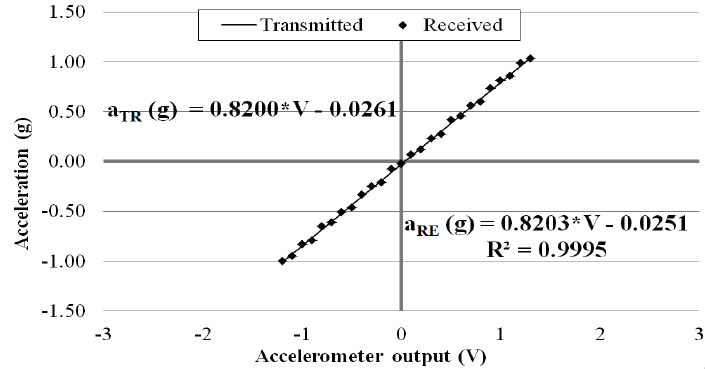
Figure 9. Calibration chart when receiver is 15 m away from transmitter.